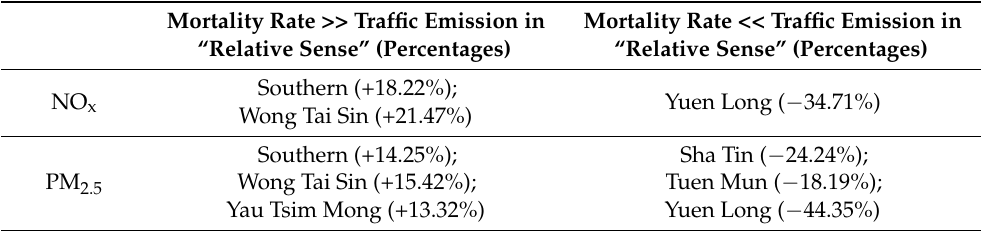
Mortality Rate << Traffic Emission in “Relative Sense” (Percentages) Yuen Long ( − 34.71%) Sha Tin ( − 24.24%); Tuen Mun ( − 18.19%); Yuen Long ( −